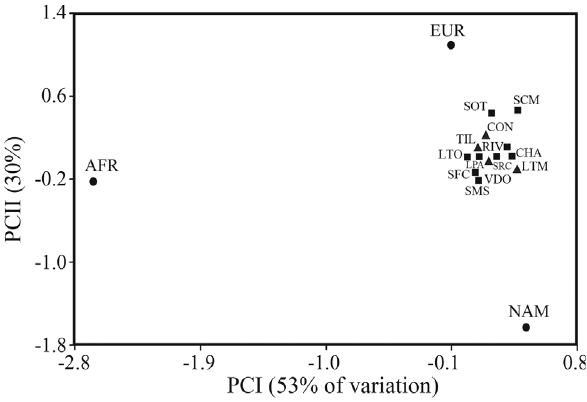
Figure 2 - Principal Component Analysis based on the frequencies of 10 AIMs in 13 populations of central Argentina and 3 parental stocks. NAM (Native American); AFR (African), EUR (European). SMS, San Marcos Sierras; LTO, La Tordilla; SFC, San Francisco del Chañar; SCM, San Carlos Minas; LPA, La Para; VDO, Villa Dolores; SOT, Villa de Soto; CHA, Chancaní; RIV, Río Cuarto; TIL, Tilisarao; SRC, Santa Rosa de Conlara;CON,Concarán;LTM,LaToma.Squaresandtrianglesrepresent sites of Córdoba and San Luis,